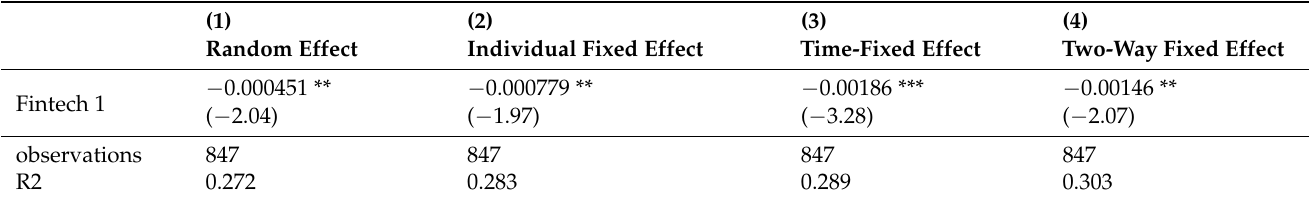
Table 6. Robustness test: replace the explanatory variable with SDROA.